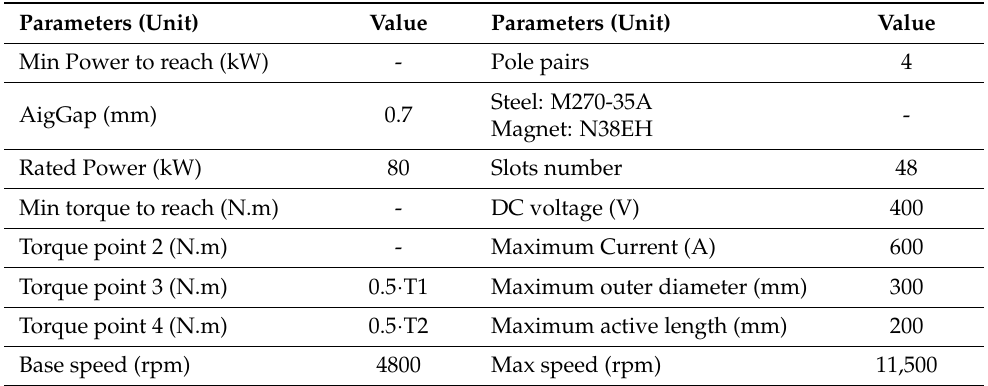
Table 2. Motor design